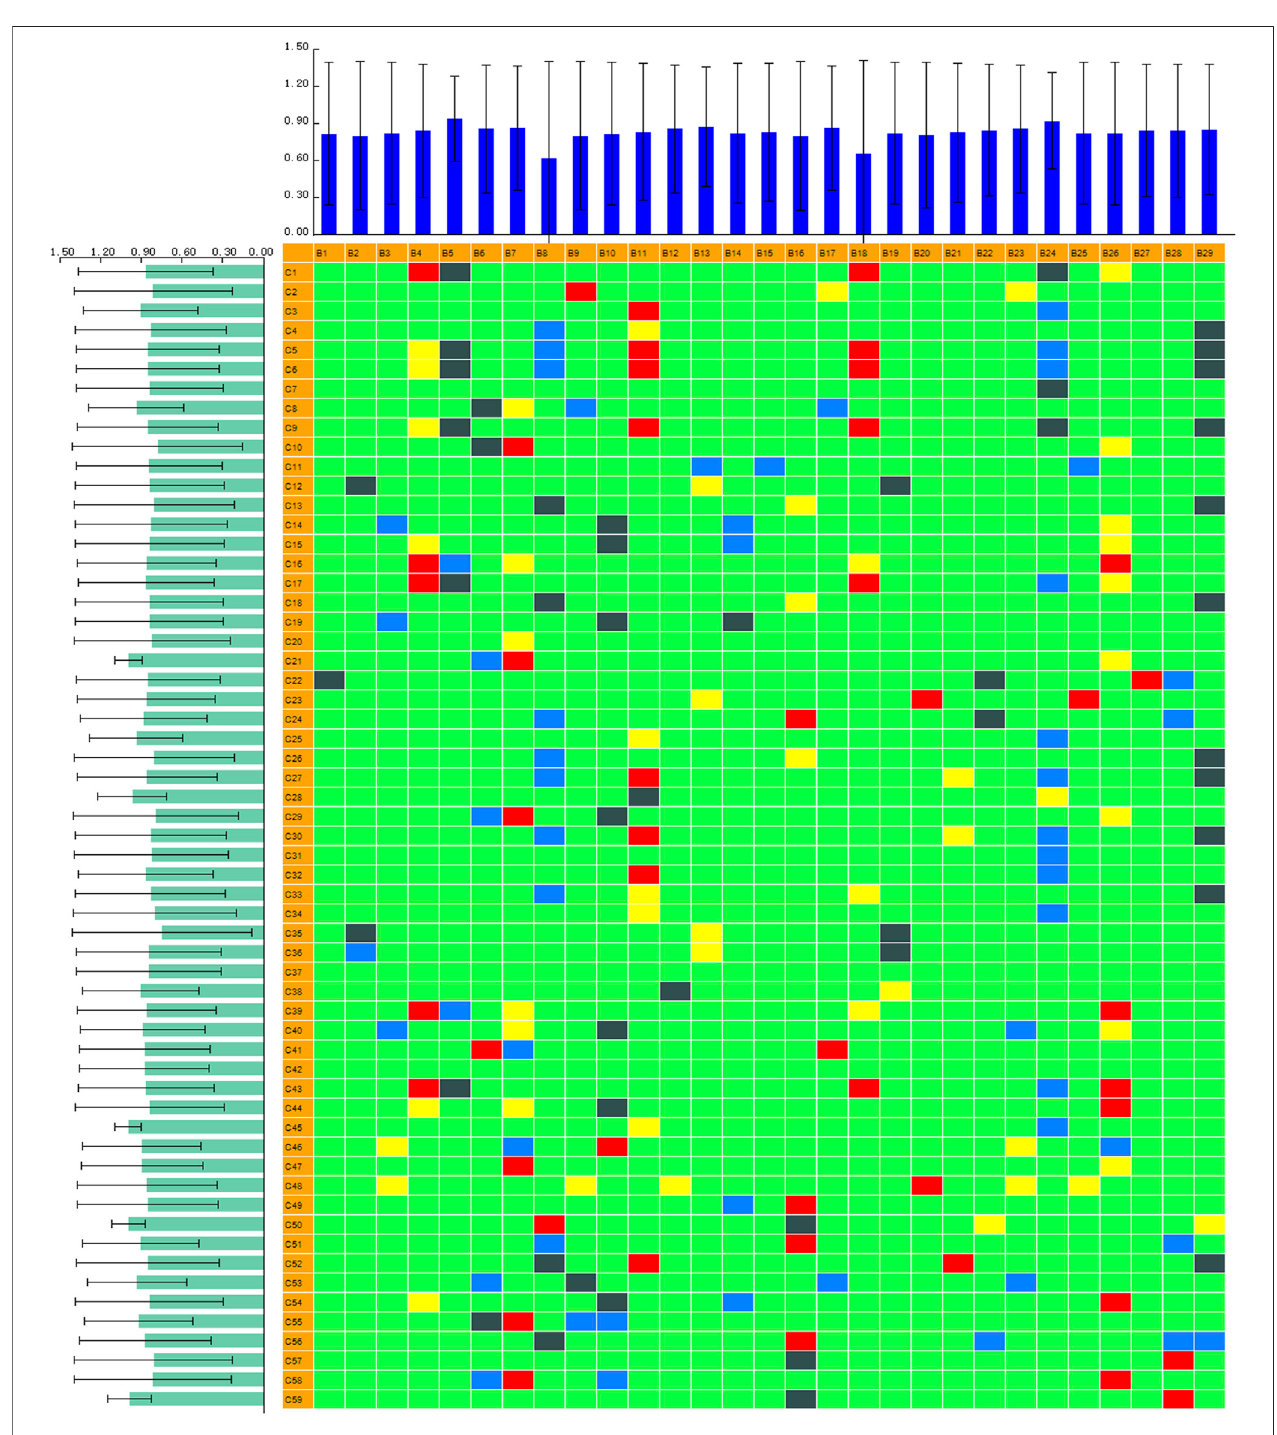
FIGURE 7 | PCMS analysis of serum biomakers and chemical constituents in the ZBD group.